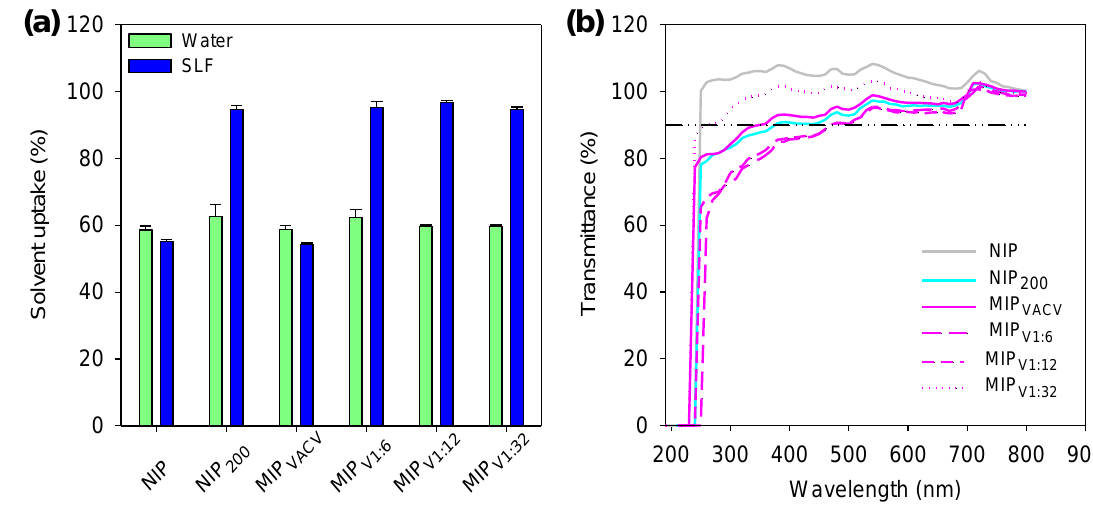
Figure 6. ( a ) Solvent (water or SLF) uptake values recorded for the hydrogels after 24 h of soaking (hydrogels codes as in Table 1), and ( b ) light transmittance values of hydrogels swollen in SLF. The acceptance value of 90% transmittance is shown as a dash-dot line.